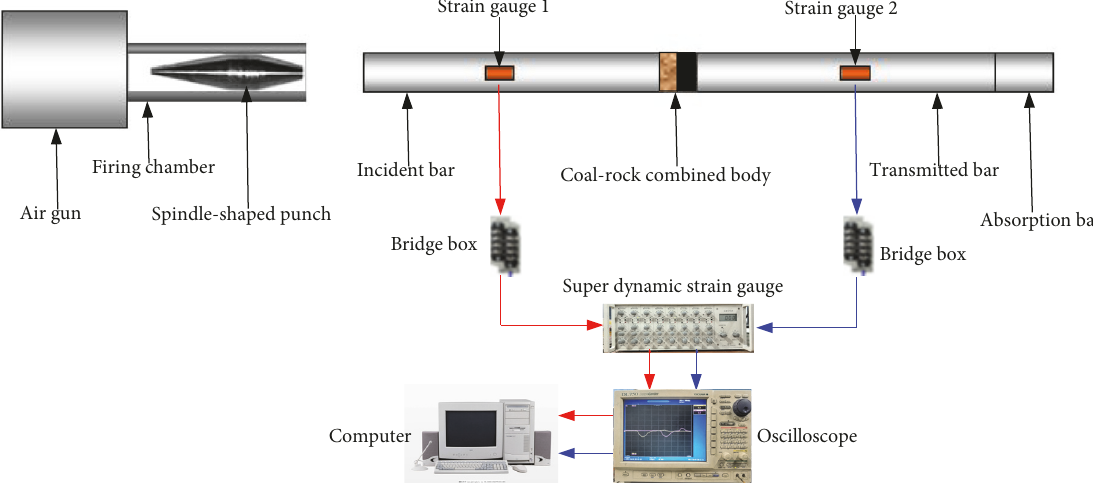
Figure 2: Experimental system sketch of SHPB